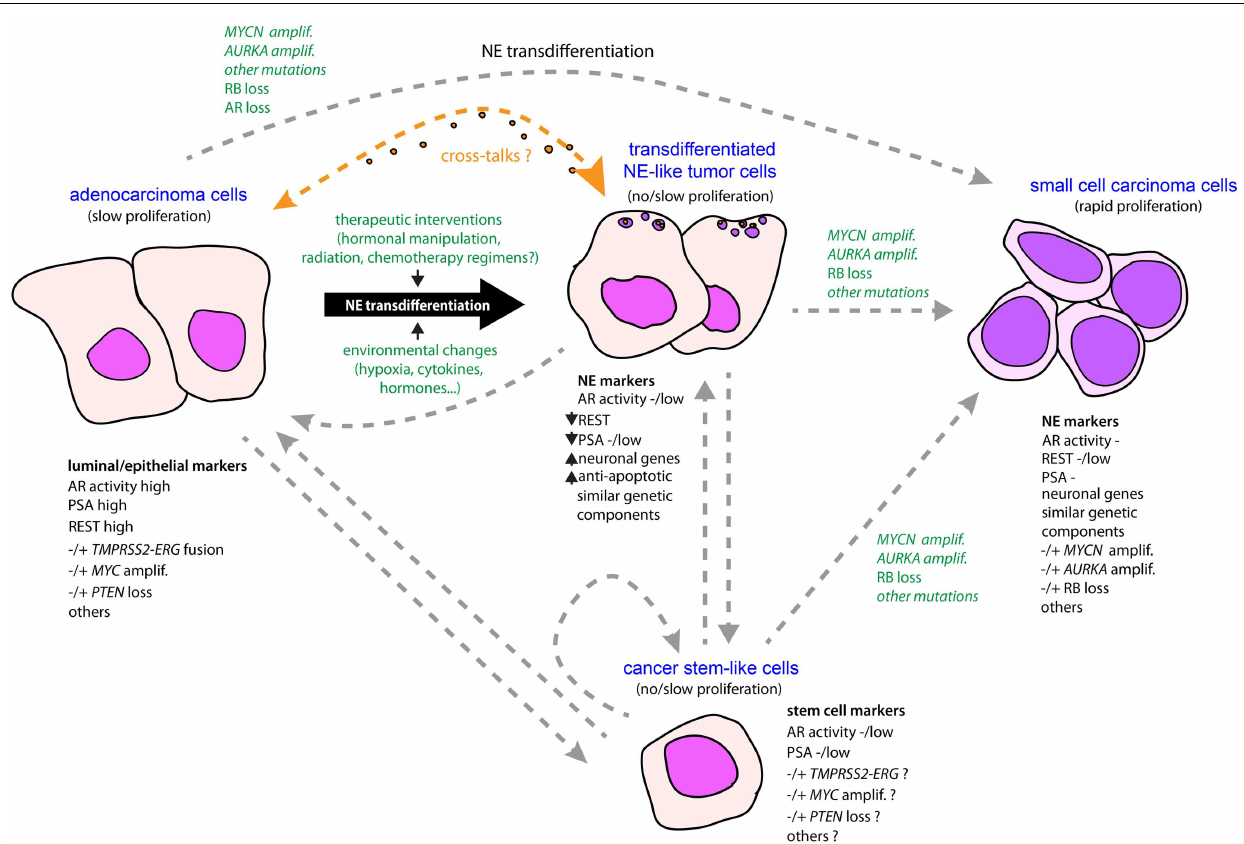
FIGURE 1 | Schematic model for the emergence of NE phenotype in tumor progression in prostate cancer. An NE-like or NE phenotype may be driven by a conjunction of molecular events and environmental changes, combined with natural selection. Owing to treatment intervention and/or certain environmental changes associated with tumor development, some adenocarcinoma cells having accumulated genetic alterations are able to transdifferentiate from epithelial-like to neuroendocrine-like tumor cells that have superior anti-apoptotic and therapeutic-resistant properties. In addition, neuropeptides and growth factors released by the NE-transdifferentiated cells may act either as autocrine or paracrine signals to promote survival and tumor progression of both NE and adenocarcinoma components. Accumulation of new genetic alterations such as RB loss,